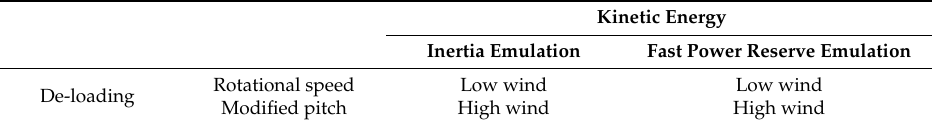
Table 1. Combination strategy.